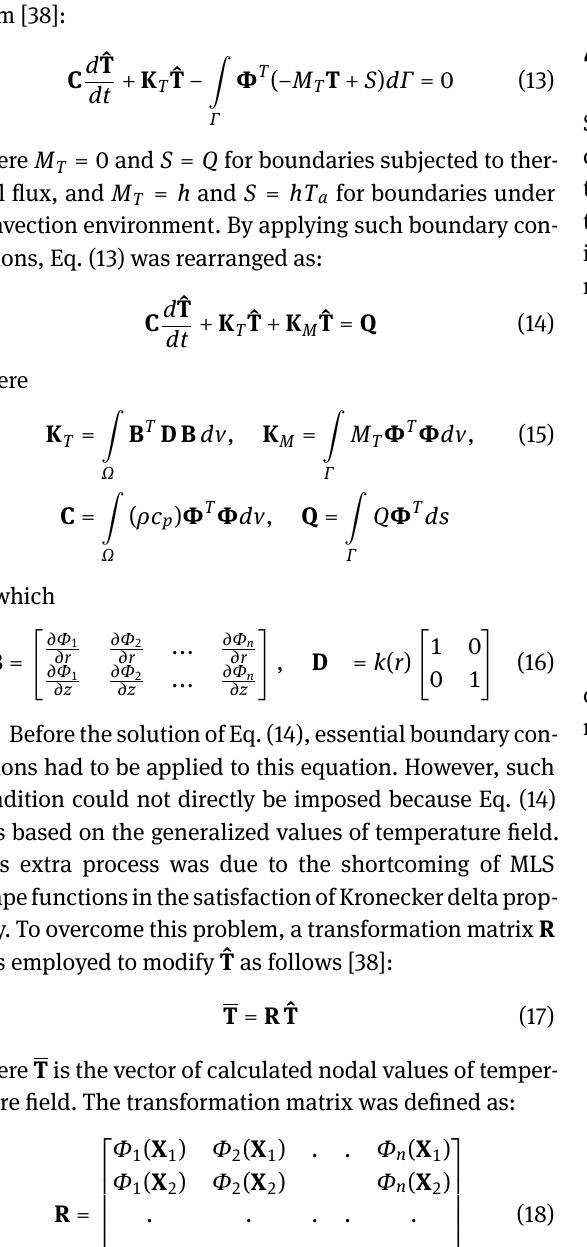
Figure 3: Thermal conductivities of graphene/PE and CNT/PE